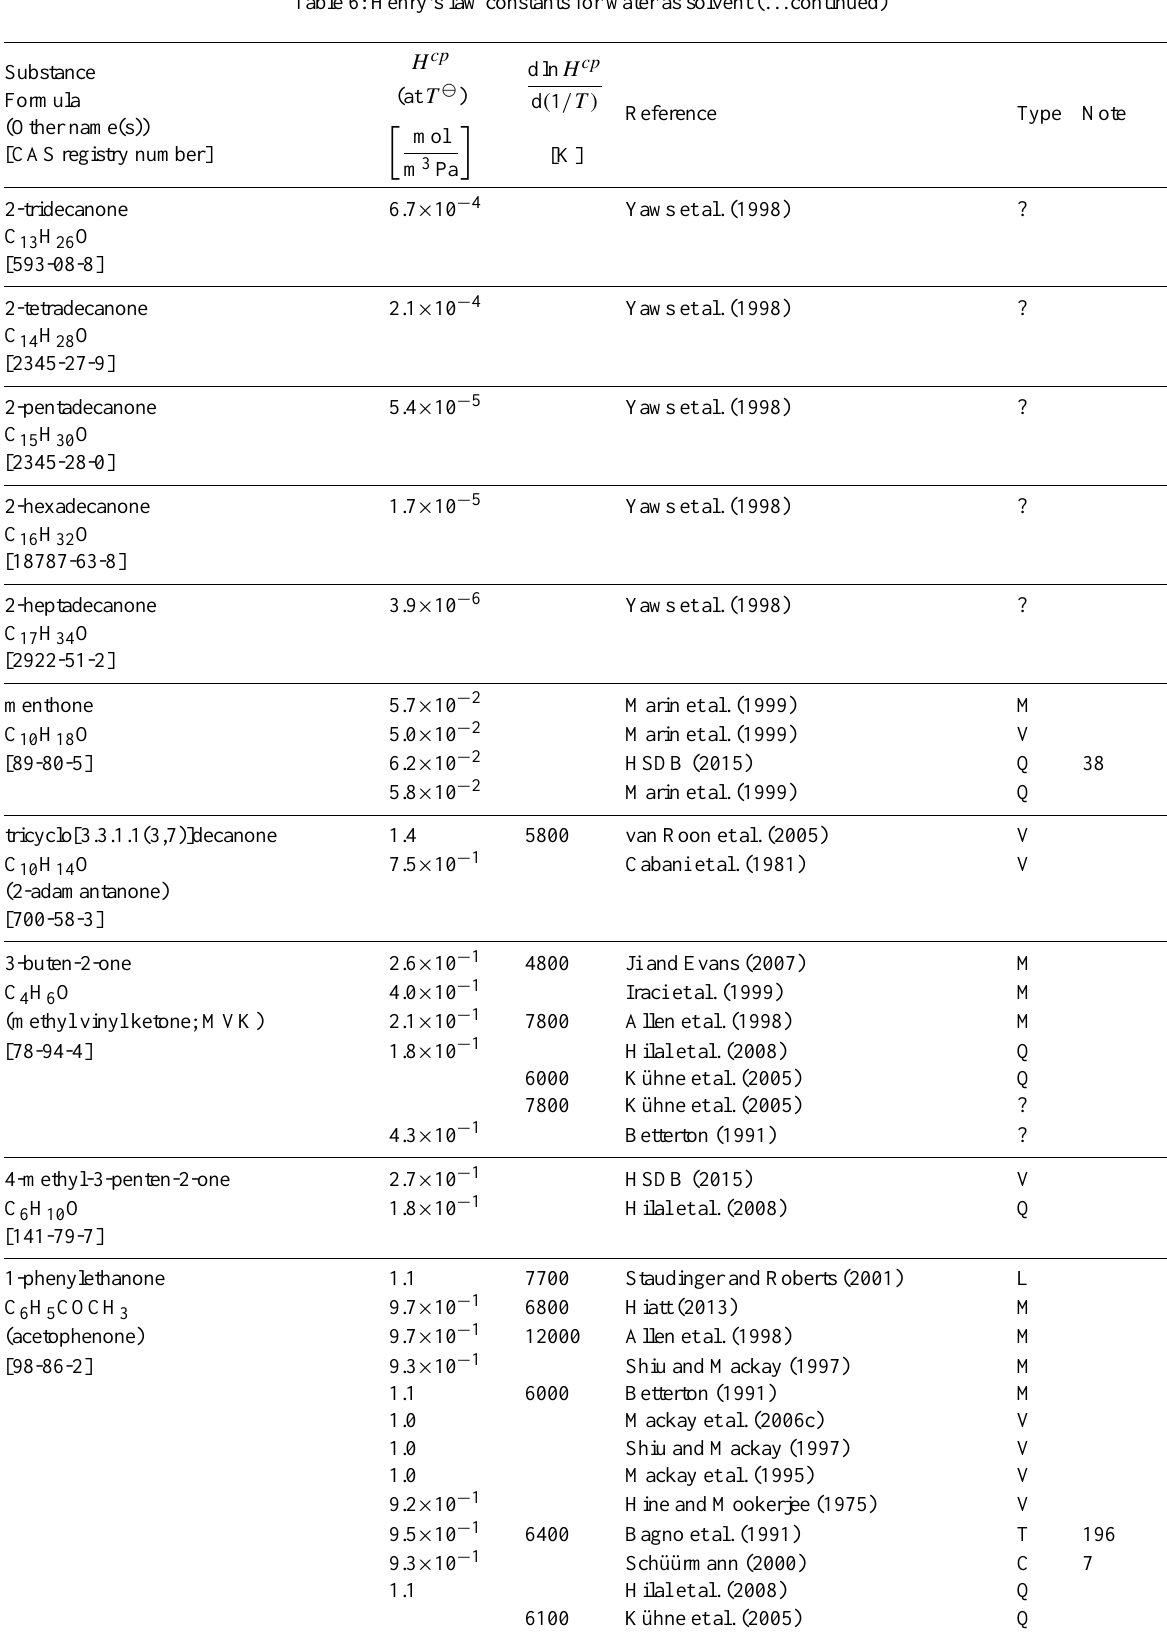
Table 6: Henry’s law constants for water as solvent